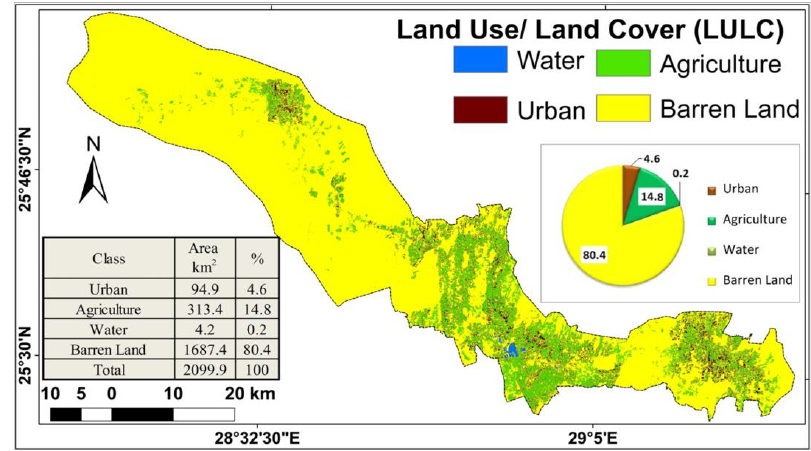
Figure 4. Land use/cover map of the area under investigation.